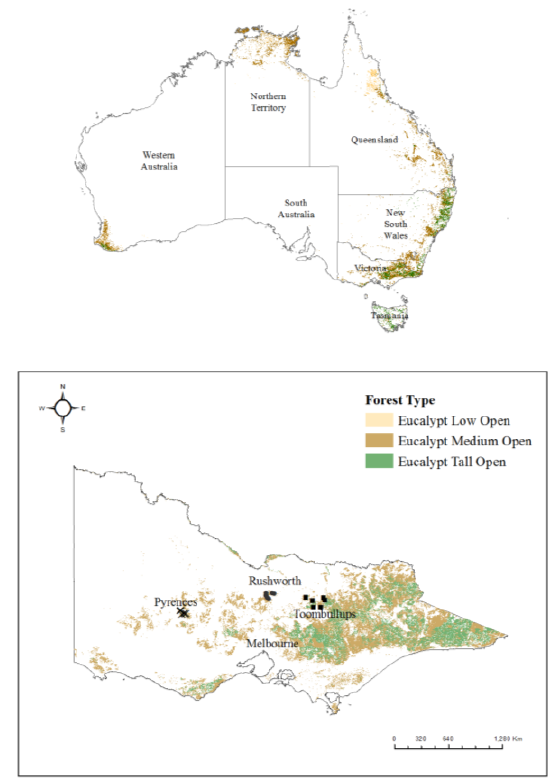
Figure 1. Study sites locations in Eucalyptus open forests of south-eastern (SE) Australia, where: × is Pyrenees, ● is Rushworth, and ■ is